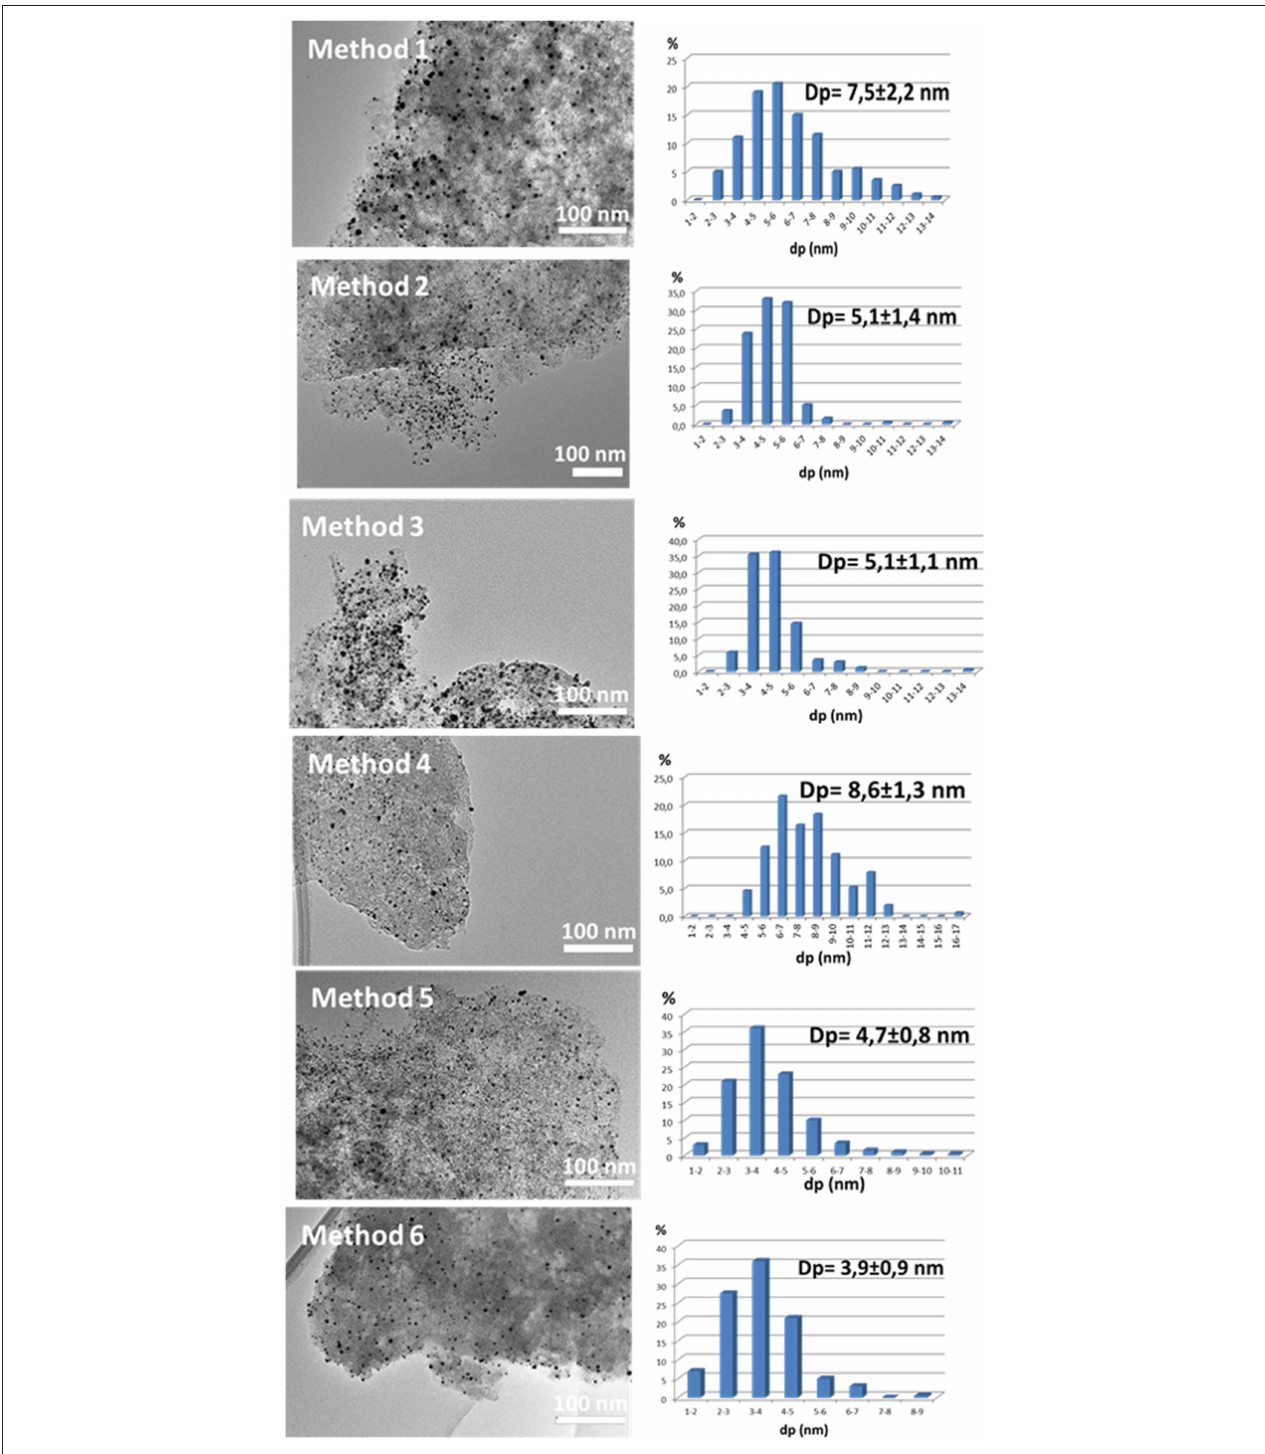
FIGURE 7 | TEM micrographs and gold particle size distribution for Au/C catalysts obtained with different calcination methods.